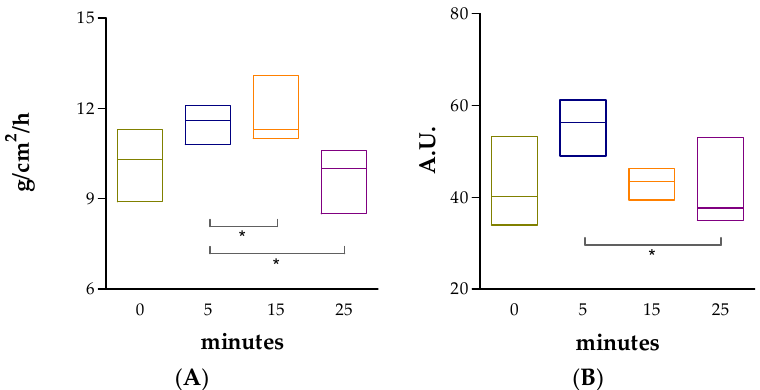
Figure 6. Tolerance studies in human individuals. ( A ) TEWL: Transepidermal water loss; ( B ) SCH: Stratum corneum hydration. Results are expressed as median, minimum and maximum ( n = 12). Statistically significant differences: * p <